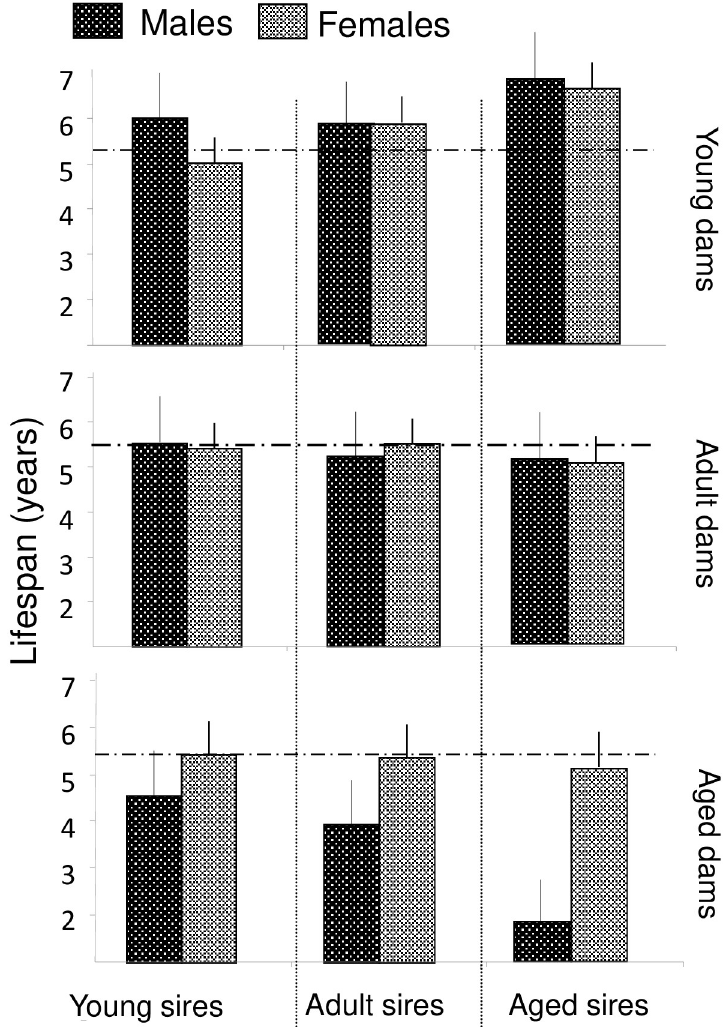
Fig 3. Lifespan (means ± SEM) of male and female offspring according to the parents’ ages within a breeding pair. The broken line indicates the mean survival (5.5 years).